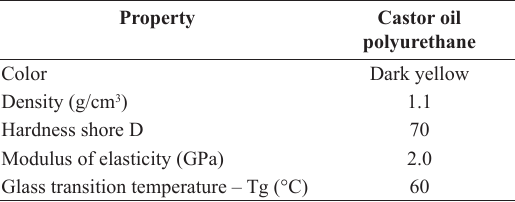
Table 1. Castor oil polyurethane resin properties. Property